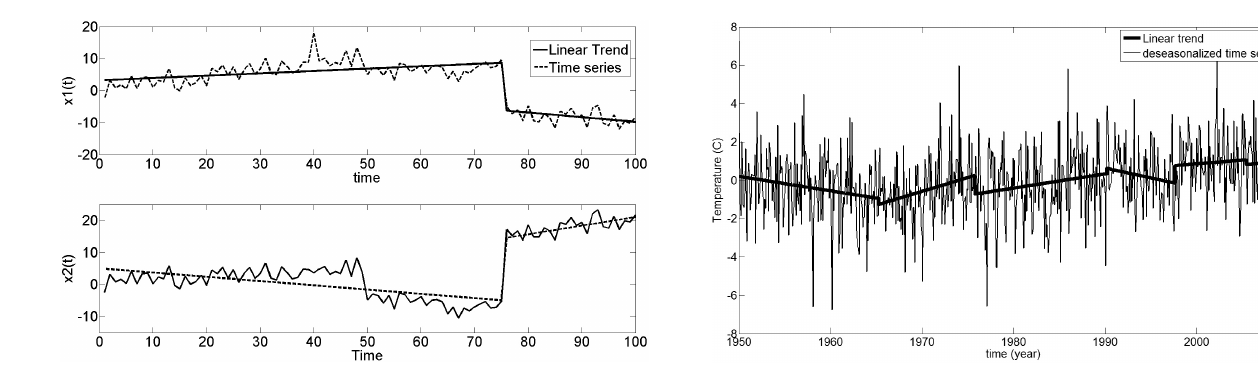
Figure 5. Result of clustering for synthetic data when K = 2 and δ = 7. The first and second clusters are merged together. Increasing the δ leads to an answer with a smaller number of switching. Figure 6. The state of NC is located in the southeastern United States. The study area covers an area of approximately 136399km 2 . A data set of average temperatures at 249 stations across NC is analyzed for the period including the beginning of 1950 till the end of October 2009.